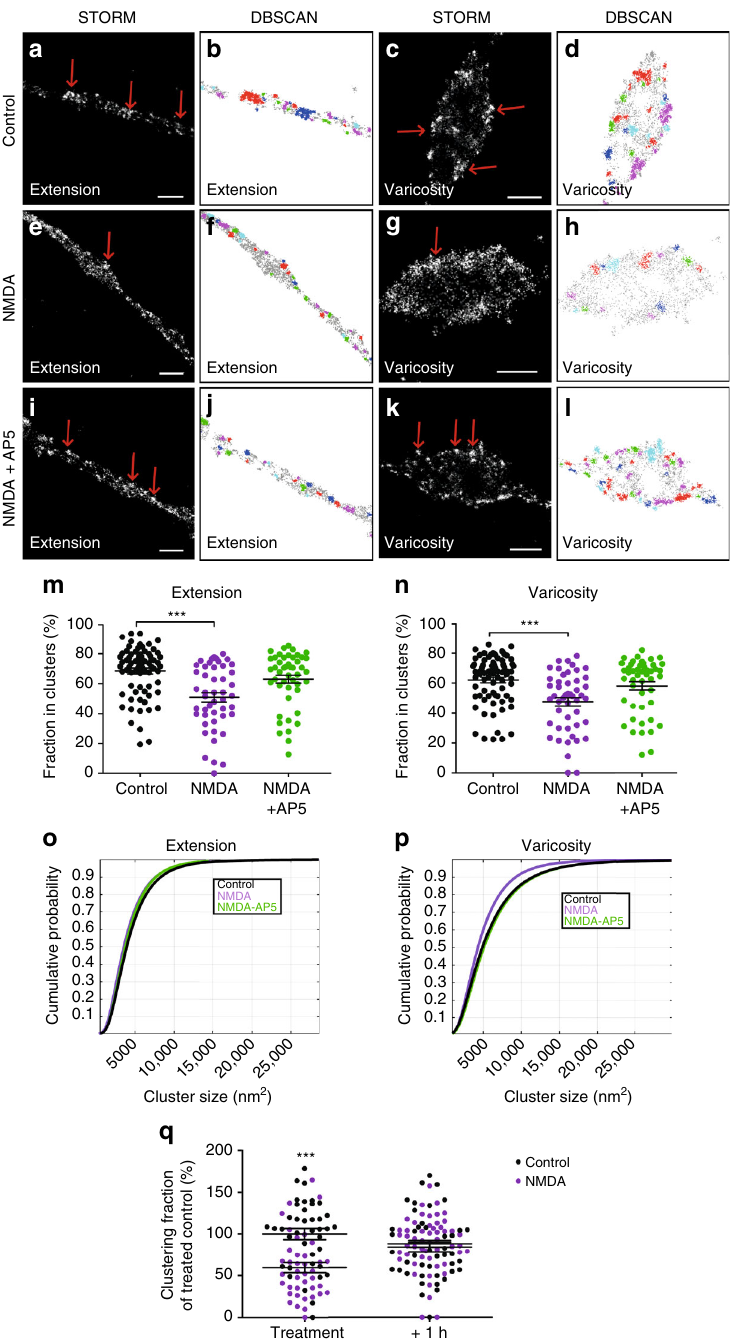
Fig. 5 NMDA stimulation of dopaminergic neurons leads to decreased clustering of DAT. a , c , e , g , i , k Representative STORM images showing DAT distribution in extensions and varicosities of dopaminergic neurons under control conditions ( a , c ), after NMDA stimulation (5 min, 20 µ M) ( e , g ), or after NMDA stimulation (5 min, 20 µ M) in presence of the NMDA receptor antagonist AP5 (100 µ M) ( i , k ). DAT was visualized by immunolabeling with primary DAT antibody and Alexa405-Alexa647-conjugated secondary antibody. b , d , f , h , j , l DBSCAN-based cluster maps of the DAT signal in a , c , e , g , i , k . Clustered localizations are shown by color-coding with non-clustered localizations in gray . m , n Quanti fi cations, based on the DBSCAN, of DAT nanodomain localization in dopaminergic neurons after NMDA or after NMDA + AP5 showing m clustering in varicosities, and n clustering in extensions. Data are fraction of localizations in clusters in % (means ± s.e.m., *** p < 0.001, one-way ANOVA and Bonferroni ’ s post-test). o , p Probability distribution of the cluster sizes in varicosities ( o ) and extensions ( p ) at control conditions ( black ) or after NMDA ( purple ) or after NMDA + AP5 ( green ). Data are from 63 to 64 images from four individual experiments. Scale bar 200 nm. q Reversibility of NMDA-induced decrease in DAT nanodomain localization. Neurons were treated for 5 min with NMDA ( purple ) or vehicle ( black ) and fi xed (treatment) or treated for 5 min with NMDA ( purple ) or vehicle ( black ) followed by a 1 h wash out before fi xation (+1 h). Data are based on DBSCAN of the resulting STORM images and shown as fraction of localizations in clusters after NMDA as percentage of fraction of localizations in clusters at control conditions (means ± s.e.m., *** p < 0.001, two-way ANOVA and Bonferroni ’ s post-test). Data are from 146 images from two individual experiments. Scale bars 500